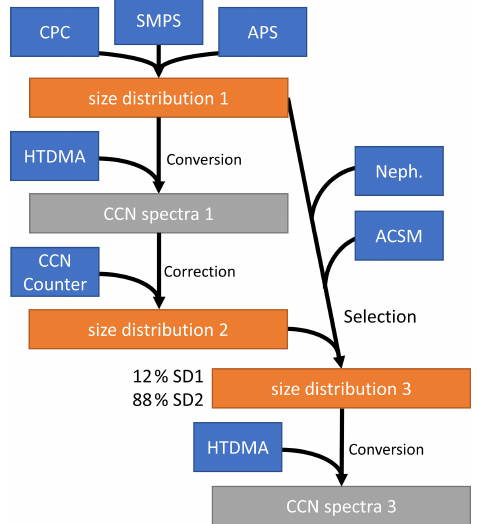
Figure A1. Flowchart illustrating the processing of data to various distributions, with input instrument data shown in blue boxes, size distributions in orange, and CCN spectra in gray.